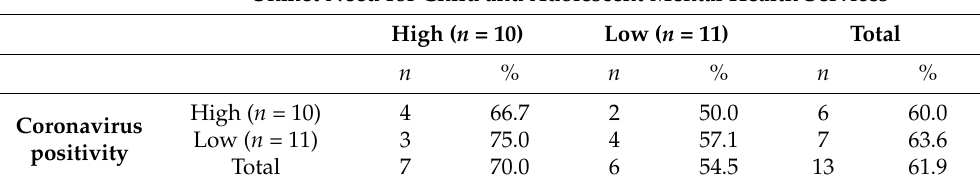
Table 4. Decrease in capacity to deliver mental health service by rates of coronavirus positivity and unmet need for child and adolescent mental health